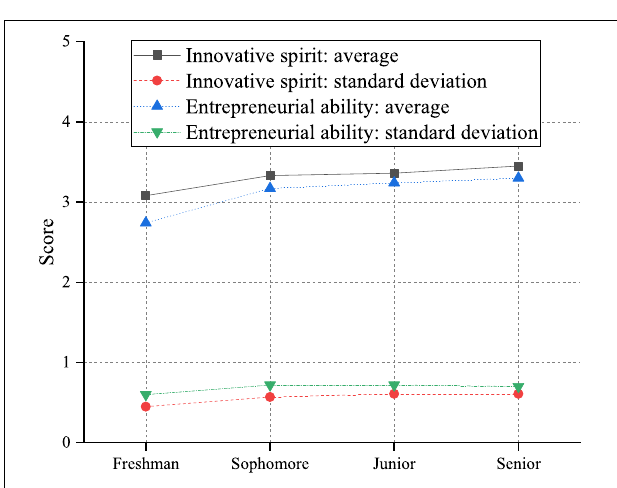
FIGURE 9 | Analysis of the impact of grade difference on innovation and entrepreneurship ability of college students.